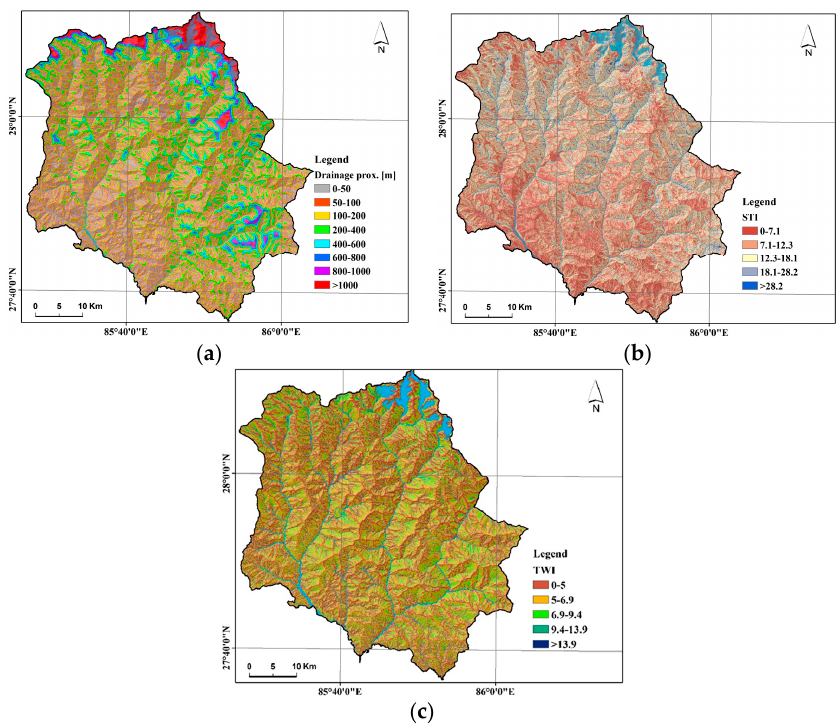
Figure 8. Hydrologic factors: ( a ) drainage proximity; ( b ) sediment transport index (STI); ( c ) topographic wetness index (TWI).